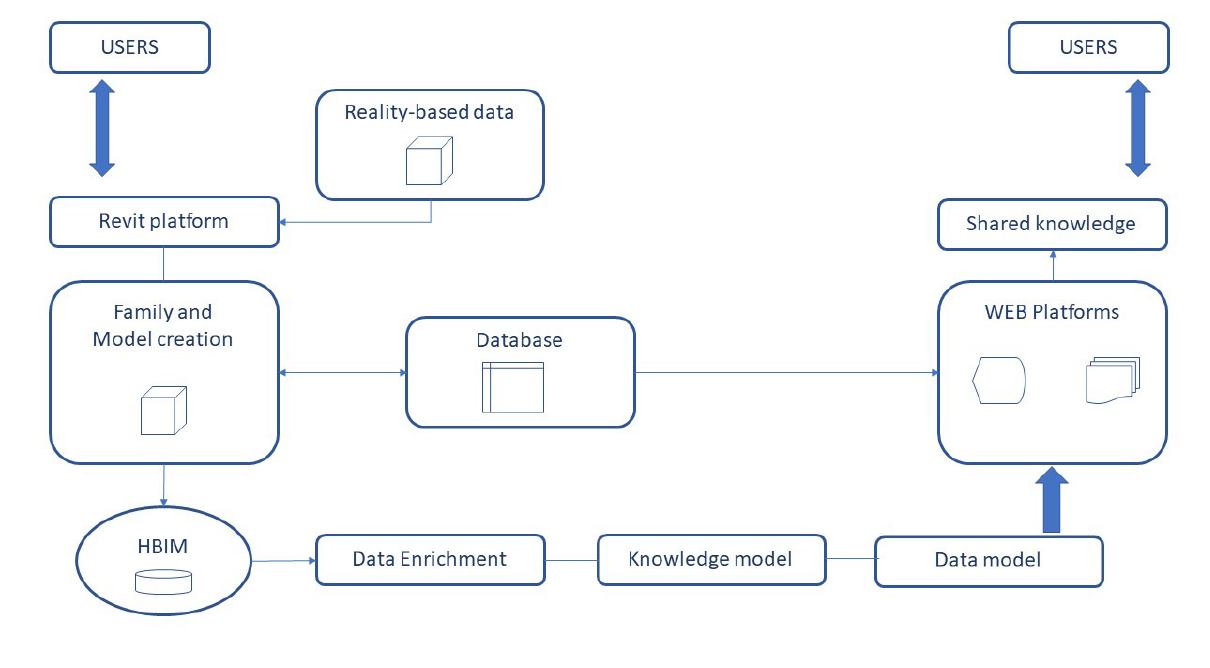
Figure 10. The schema of the